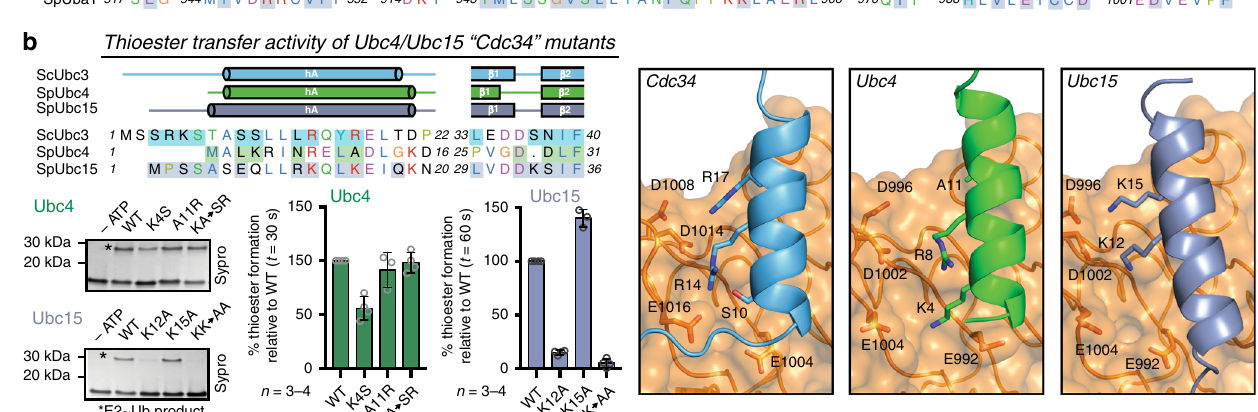
Fig. 4 The E1/Cdc34-binding mode is achieved via a unique network of contacts. a Top , interface between E2 and Uba1 UFD with involved residues shown as sticks for Cdc34 ( left ), Ubc4 ( middle ), and Ubc15 ( right ); colored as in Fig. 3. Dashed circles indicate UFD acidic patch binding region. Middle , open-book electrostatic surfaces of the E2/UFD interface with UFD footprint mapped onto E2 ( left ) and E2 footprint mapped onto UFD ( right ) for each E2 above. Bottom , sequence alignment of ScUba1 and SpUba1 AAD and UFD with corresponding secondary structure cartoon shown above sequence. Shaded boxes indicate Uba1 residues that interact with the corresponding E2: Cdc34 (blue), Ubc4 (green), and Ubc15 (gray). b Top left , sequence alignment of E2 UFD/ AAD-interacting region with secondary structure cartoon and interacting residues shaded as in a . Bottom left , E1-E2 thioester transfer assays of the indicated mutants for Ubc4 and Ubc15. Data are represented by mean ± SD with representative replicates labeled to the left and individual replicates shown as gray circles. Biochemical assays have four independent replicates, unless indicated by an asterisk when there are three replicates. Source data are provided as a Source Data fi le. Right , interface between UFD acidic patch and E2 hA residues corresponding to Cdc34